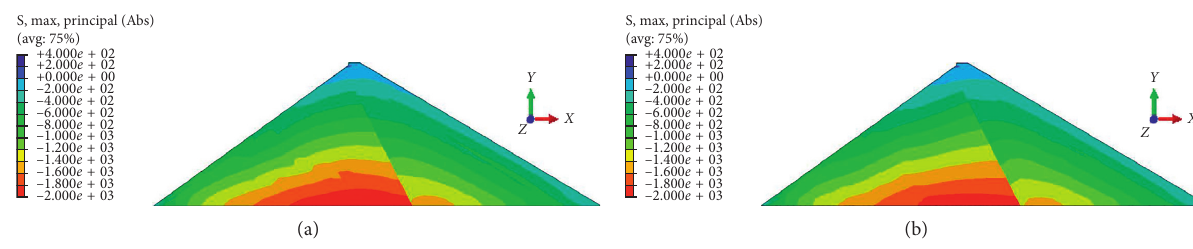
Figure 9: Major principal stress nephogram at section D0 +163.8 after 3 years of water storage. (a) Without creep. (b) Creep.